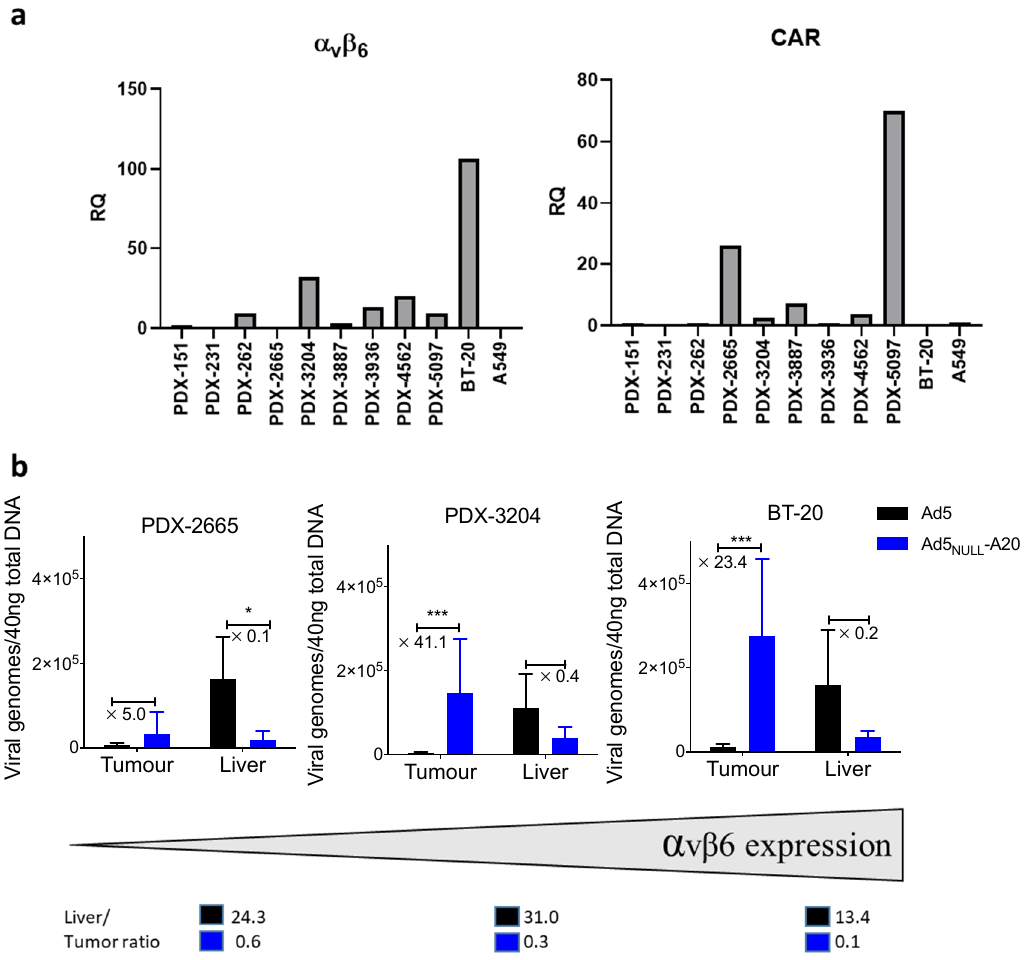
Figure 4. Biodistribution of Ad5 and Ad5 NULL -A20 in an in vivo breast cancer model : A panel of PDX breast cancer lines ( a ) were analyzed by RT-qPCR to determine levels of αvβ6 and CAR, gene expression relative to A549 cell line. PDX and BT-20 tumors were established in NSG mice ( b ), when tumors reached a palpable size, mice were injected intravenously with 1 × 10 11 vp of Ad5 (black bars) or Ad5 NULL -A20 (blue bars). Forty-eight hours postinjection, organs were harvested, and qPCR for viral genomes was performed (* p < 0.05; *** p < 0.001). Liver/tumor ratios are included below the graphs.